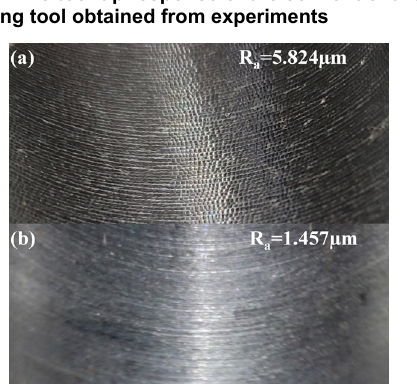
Figure 14. The surface of the machined component in internal turning with (a) the conventional and (b) CLD boring